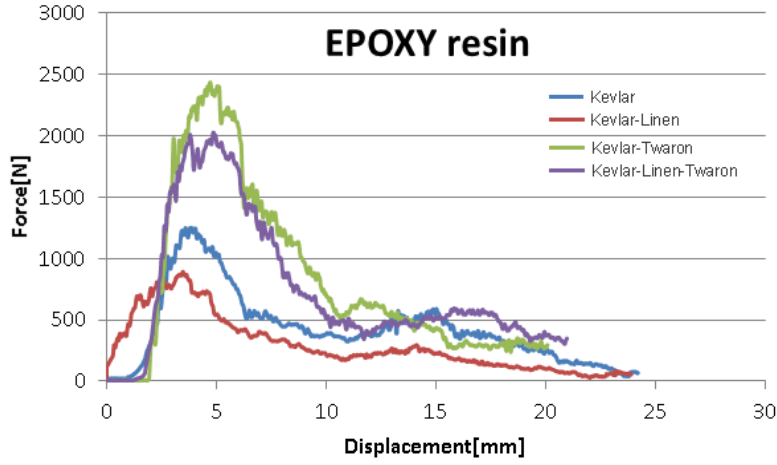
Figure 10. Force displacement curves—EPOXY resin .